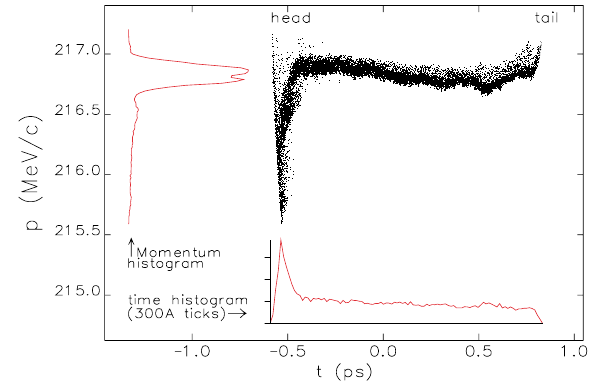
FIG. 2. (Color) Typical longitudinal phase space at the end of the linac (300 A case).